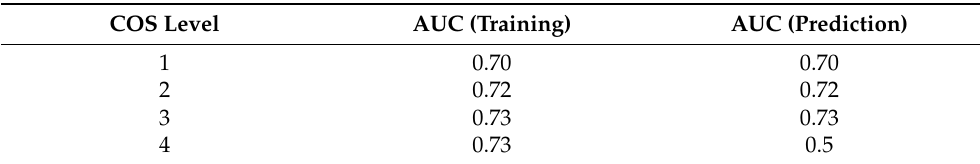
Table 8. Results of the validation of susceptibility models generated with training area 3, 6 years of occurrences and different COS levels.